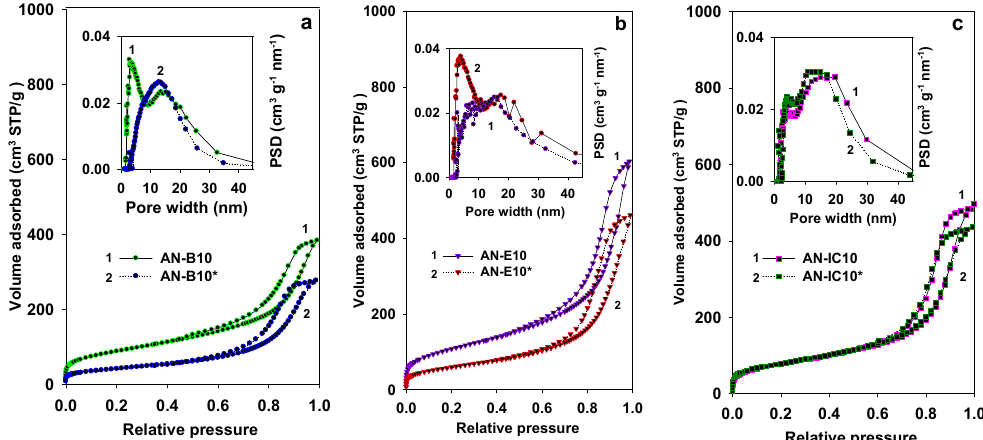
Figure 4. N 2 adsorption isotherms and their corresponding PSD curves (insets) for the extracted (AN-